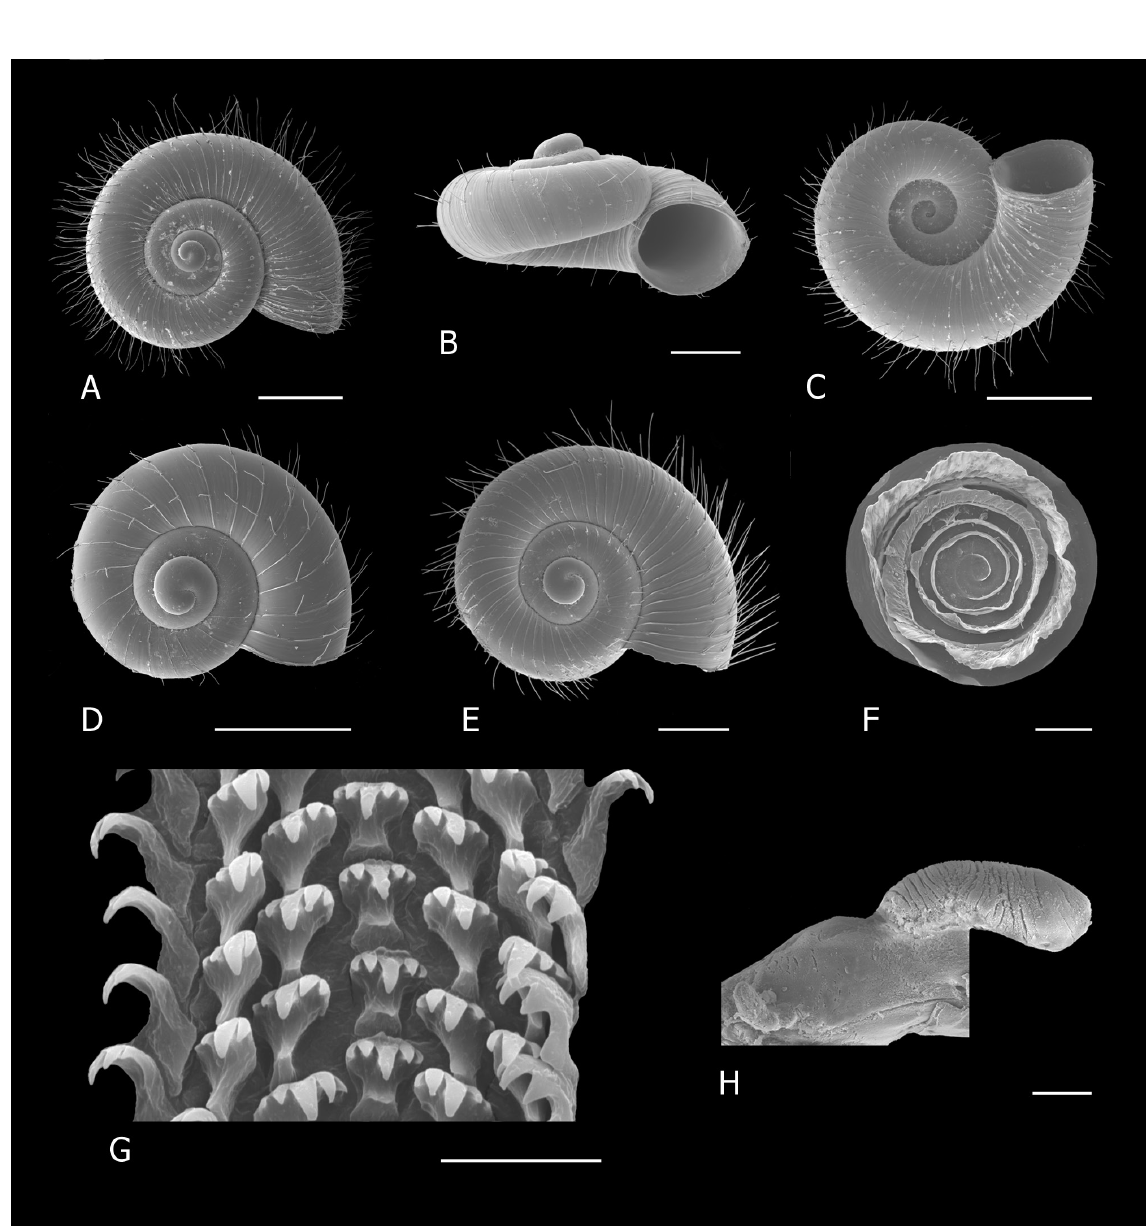
Fig. 31. Afrocyclus potteri gen. et sp. nov. A . Dorsal view (ELM D14713). B . Aperture view (ELM W4052). C . Ventral view (ELM D18233). D–E . Juveniles to show variation in detail of axial lamellae of periostracum from different populations: D . Juvenile from type locality (ELM W4052). E . Juvenile from Langeni (ELM D17151). F . Operculum (ELM W4052). G . Portion of radula (ELM W3933). H . Penis, lateral view (ELM W4052). Scale bars: A, C = 1 mm; B, D–E = 500 µm; F, H = 200 µm; G = 20